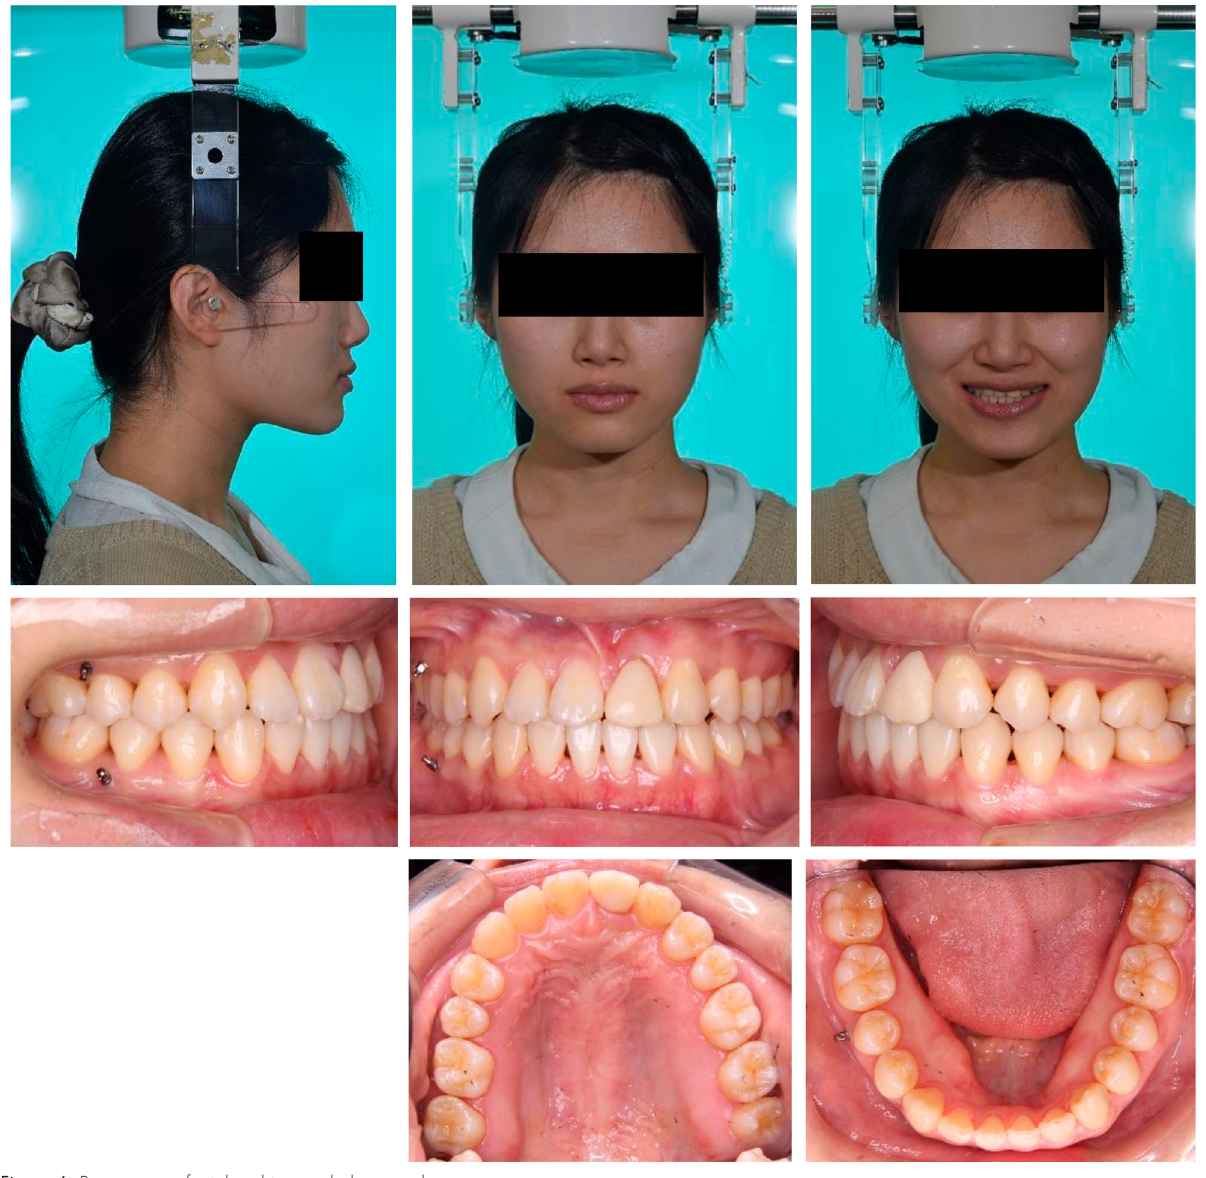
Figure 6. Posttreatment facial and intraoral